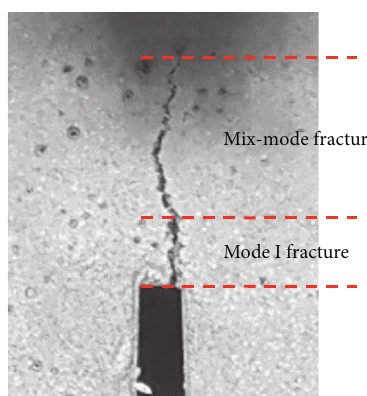
Figure 15: Separation of the mode of fracture in accordance with geometry of the crack. Table 3: Summary of the three-point bending test